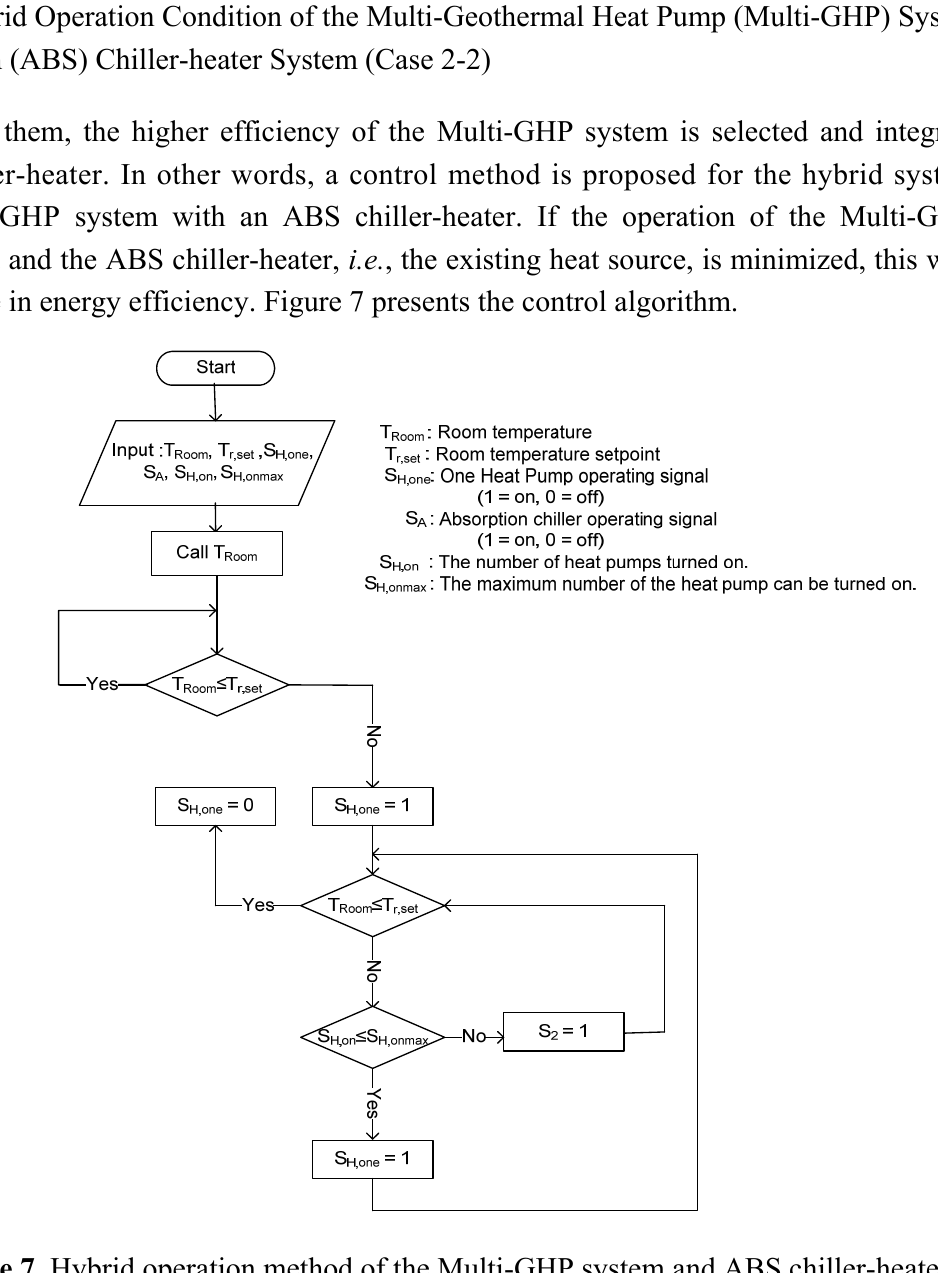
Figure 7. Hybrid operation method of the Multi-GHP system and ABS chiller-heater system. ① Multi-GHP system is not